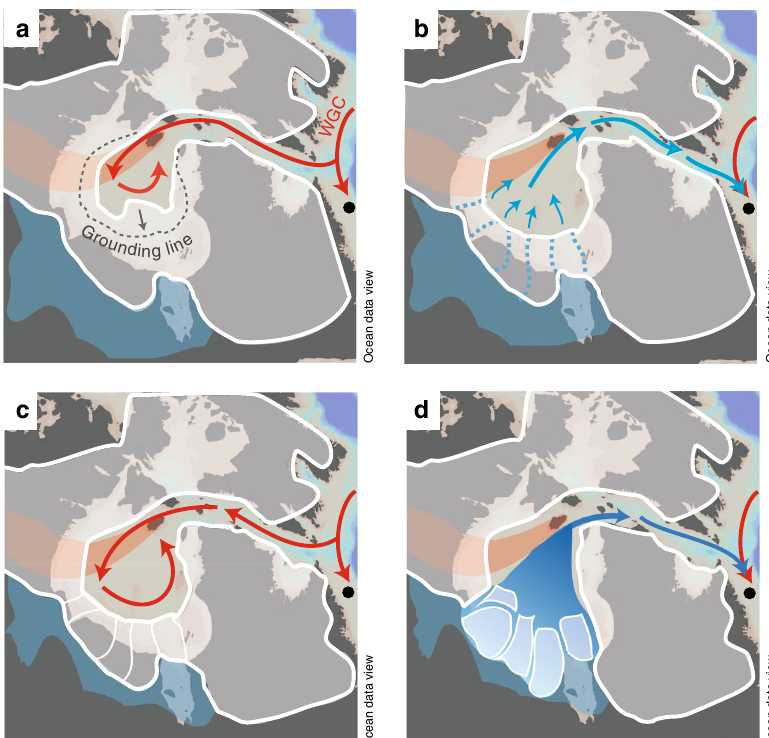
Fig. 5 Schematic areal views of the Hudson Bay Ice Saddle collapse between 8.7 – 8.4 ka before present. A black circle marks the location of core MSM45- 19-2 on the northern Labrador Shelf. a In fl owing warmer Atlantic waters from the West Greenland Current (red arrows) could have caused a retreat of the ice saddle grounding line in Hudson Bay. b As the Hudson Bay Ice Saddle became narrower (through subsurface warming) and lower (through surface ablation), it could no longer withstand the hydraulic pressure of Lake Agassiz-Ojibway with a lake level of 230 m above sea level 15 . The hydraulic pressure would have caused fractures and a partial uplift of the ice dam, which would have allowed the subglacial drainage of lake waters underneath the ice dam and through Hudson Strait into the Labrador Sea (blue arrows). The drainage would have stopped once the lake level dropped to sea level. c The fractured and now basally decoupled ice dam could have been further melted by in fl owing warmer Atlantic waters. d The break-off of fault-bounded sections would have caused the collapse of the Hudson Bay Ice Saddle, leading to the discharge of large icebergs and high volumes of freshwater (blue arrows) into